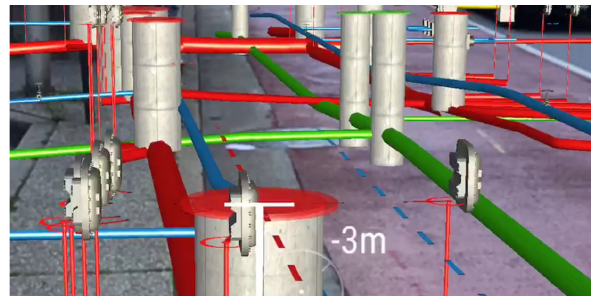
Figure 4. Crowded AR scene (Kci, 2022)